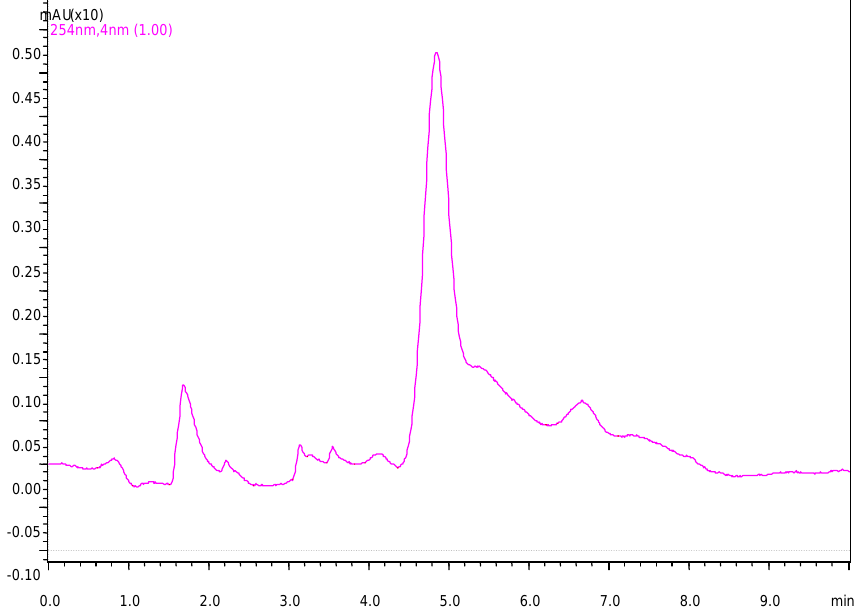
Figure 3. Chromatogram of WS-13 showing the presence of carbaryl (Retention time 4.84